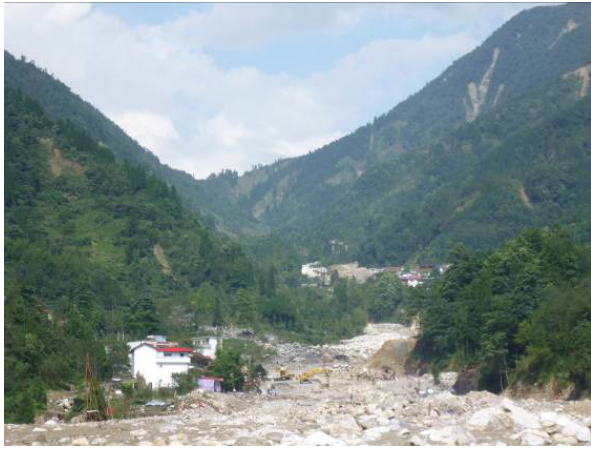
Fig. 9. An overview of the Zoumaling gully debris flow.